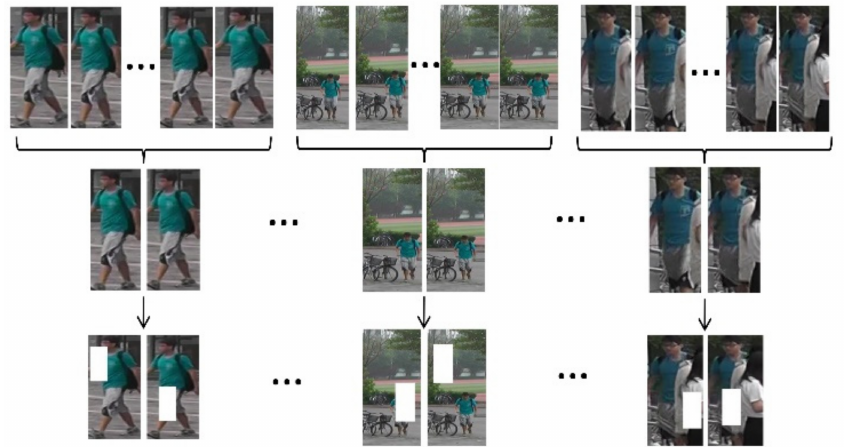
Figure 3. Pipeline of frame sampling–random